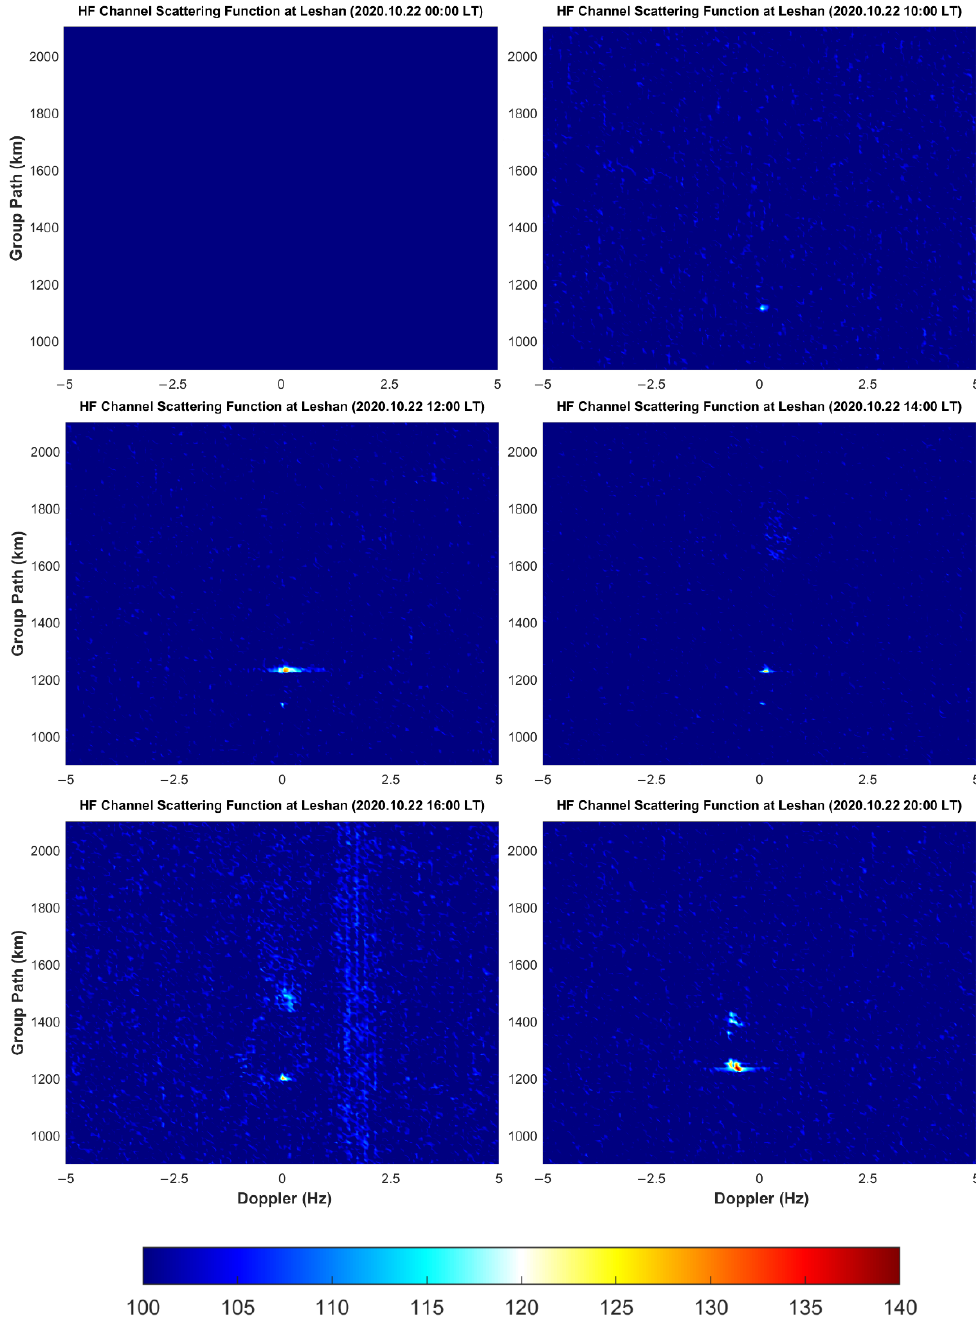
Figure 3. 22 October 2020, data processing results of Leshan station. Refer to the captions in Figure 2 for the receiving time and other descriptions of each panel. The difference from Figure 2 is that at 20:00 LT (bottom right) the Wuhan receiver can still receive the HF signals from the Leshan